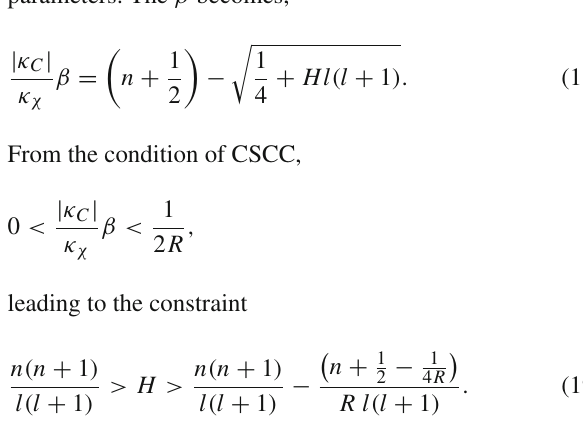
Table 1 Upper and lower bounds of H covering 35